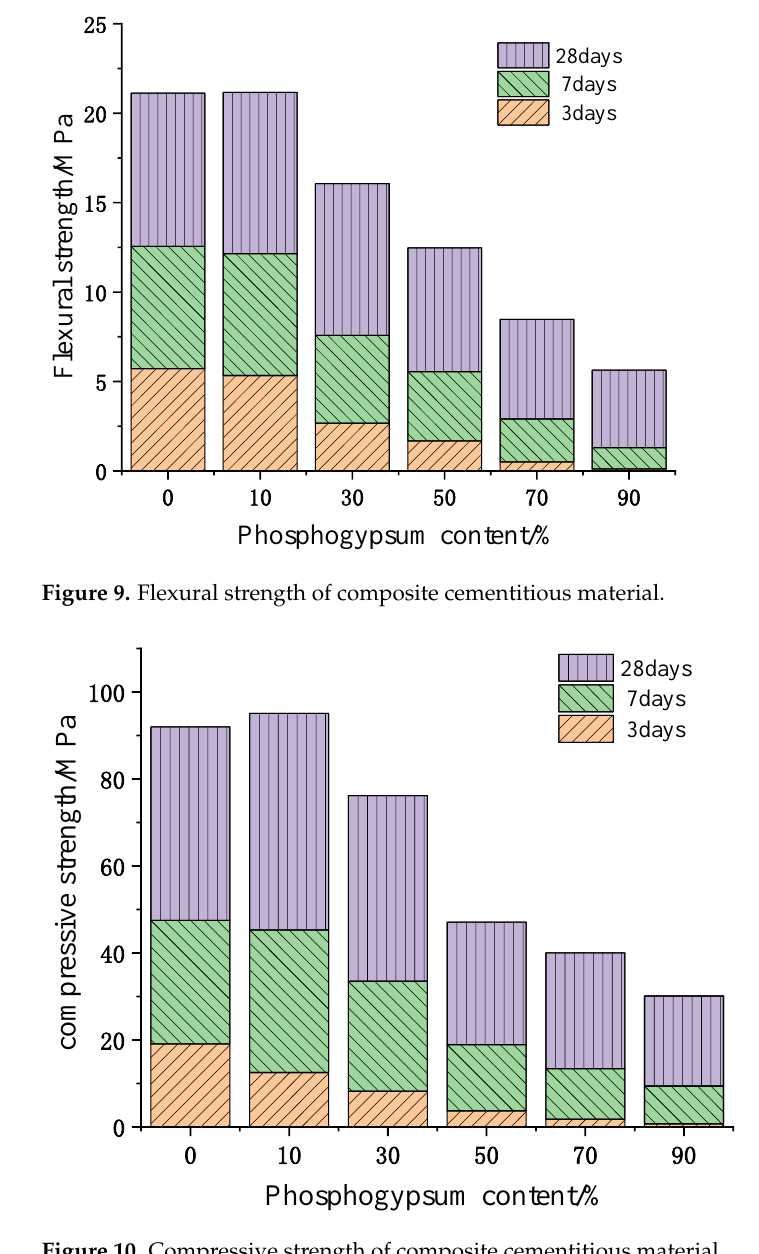
Figure 10. Compressive strength of composite cementitious material.